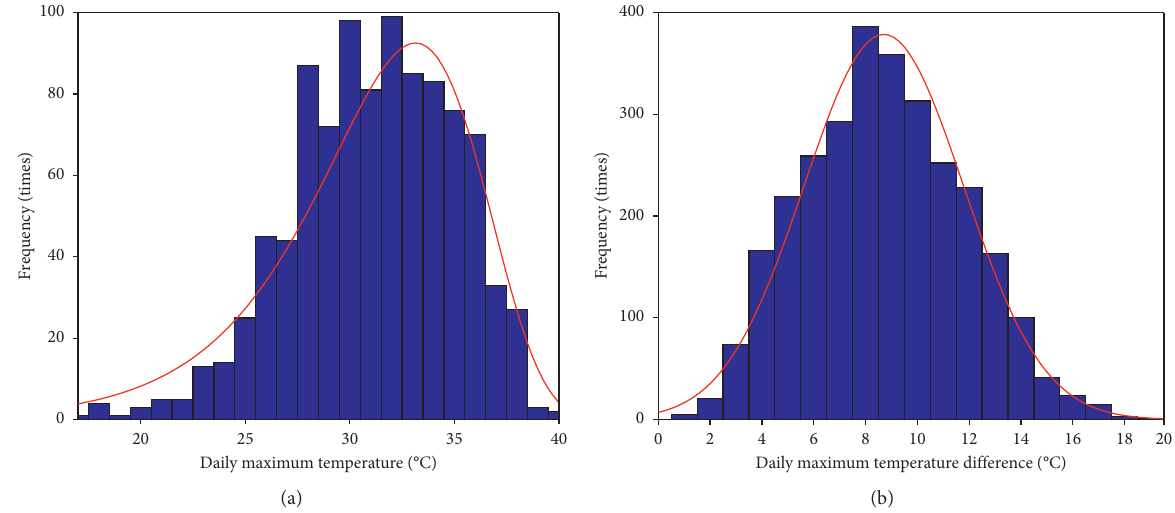
Figure 11: Probability distribution curve. (a) Gumbel distribution. (b) Normal distribution.